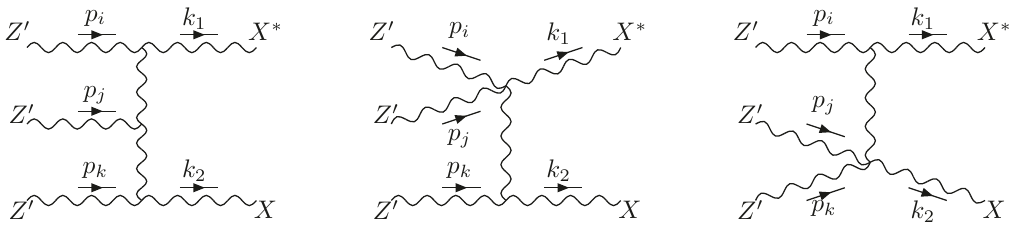
Figure 2 . Feynman diagrams of Z 0 + Z 0 + Z 0 → X ∗ + X processes. There are 6 independent diagrams with i, j, k = 1 , 2 , 3 and i 6 = j 6 = k for the first plot, while 3 independent diagrams each for the second and third